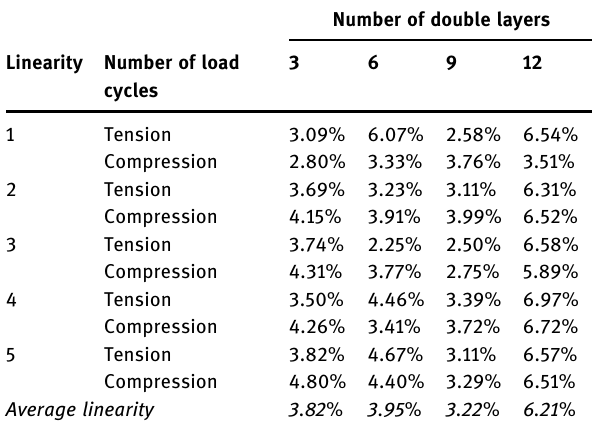
Table 1: Linearity of resistivity – displacement curves for di ff erent double layers of fi lms